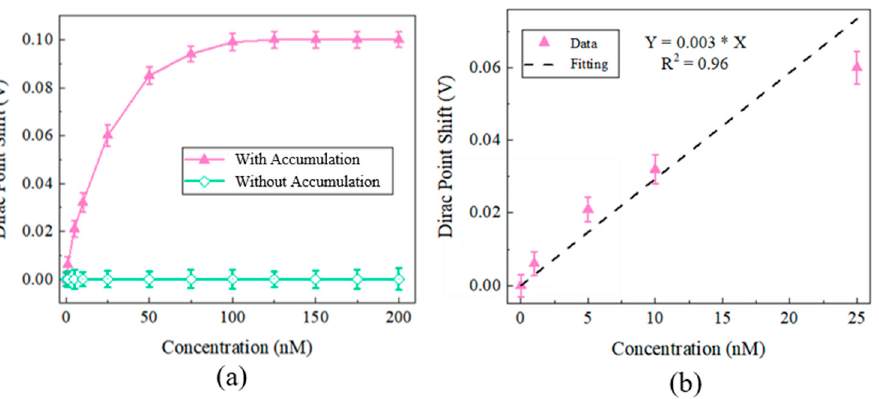
Figure 5. ( a ) Dirac point shifts at various concentrations with and without accumulation. ( b ) The relationship between the detection IgG concentration and the Dirac point shift.